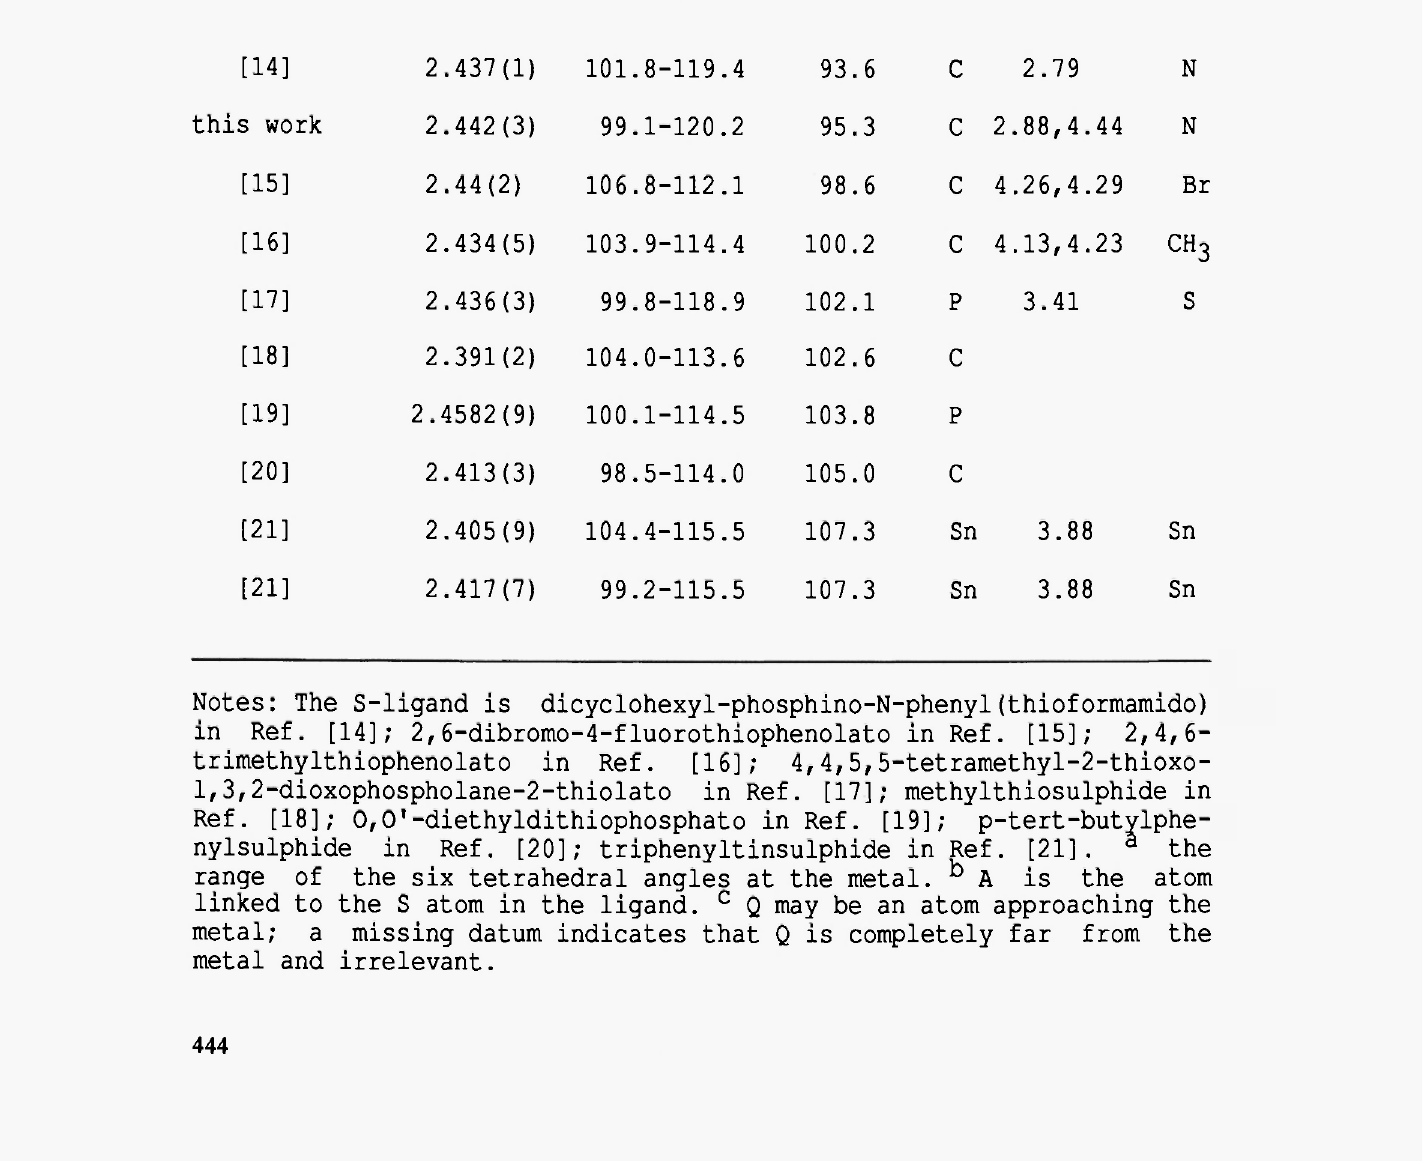
Selected Geometrical Parameters in Ph3Sn-"S"